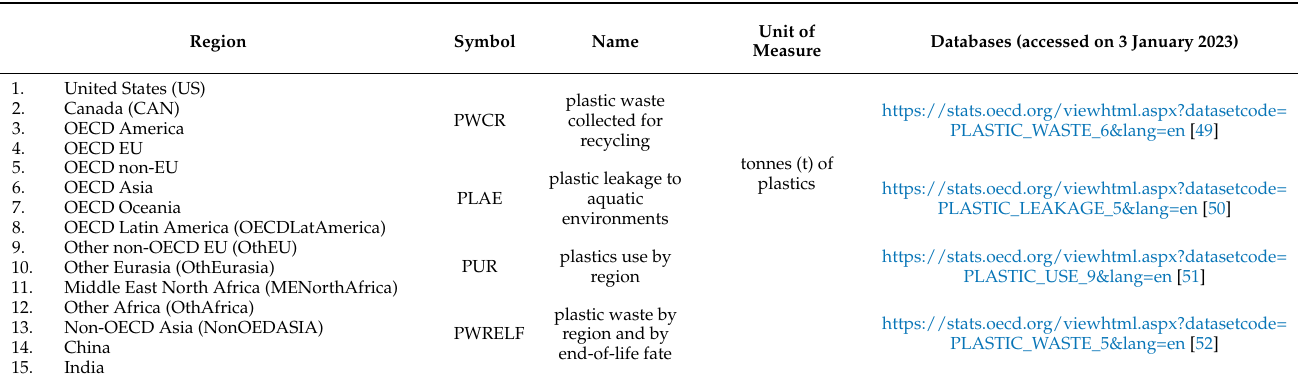
Table 1. Description of the indicators used in the